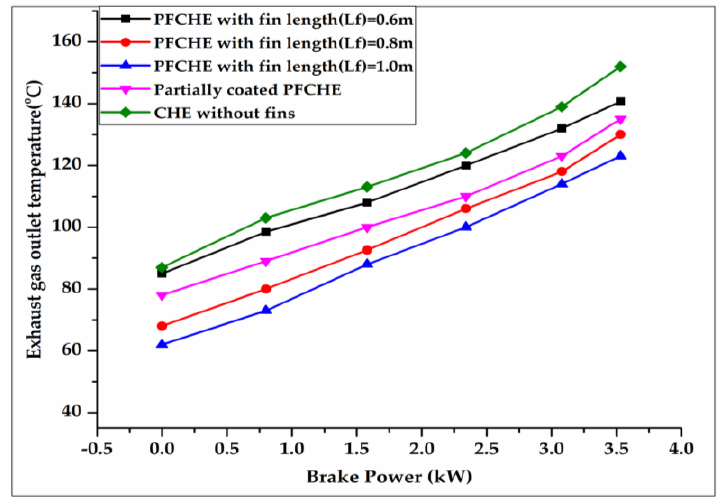
Figure 4. Variation of exhaust gas outlet temperature with fin geometry.